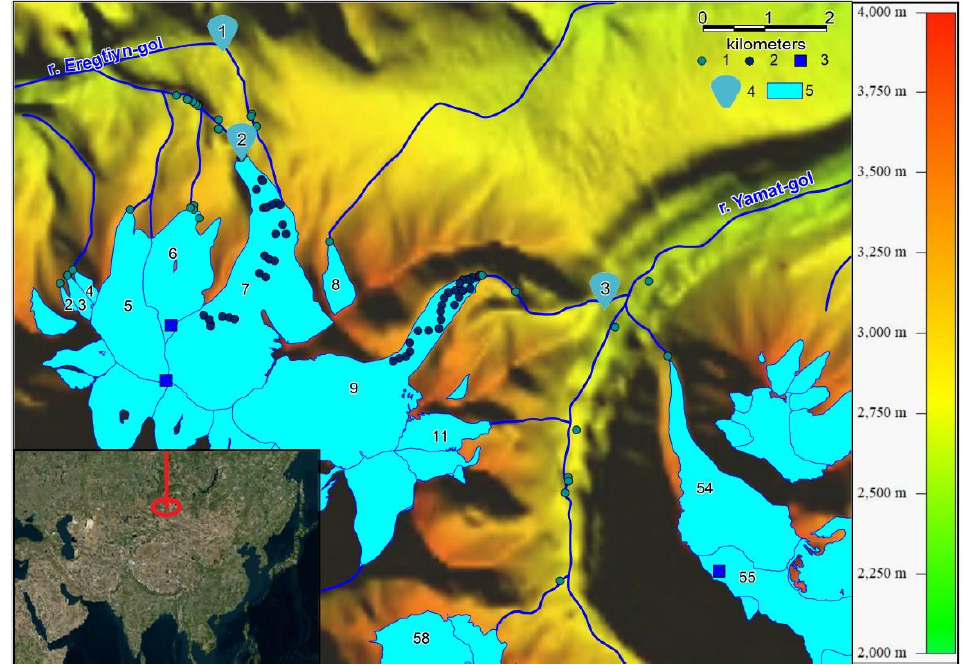
Figure 1. Position of the sampling sites in 2017. Sampling sites: 1—Water from rivers, 2—glacier ice, 3—snow and firn; 4—hydrological and isotopic composition monitoring stations, 5—present glaciers (glacier numbers are indicated).